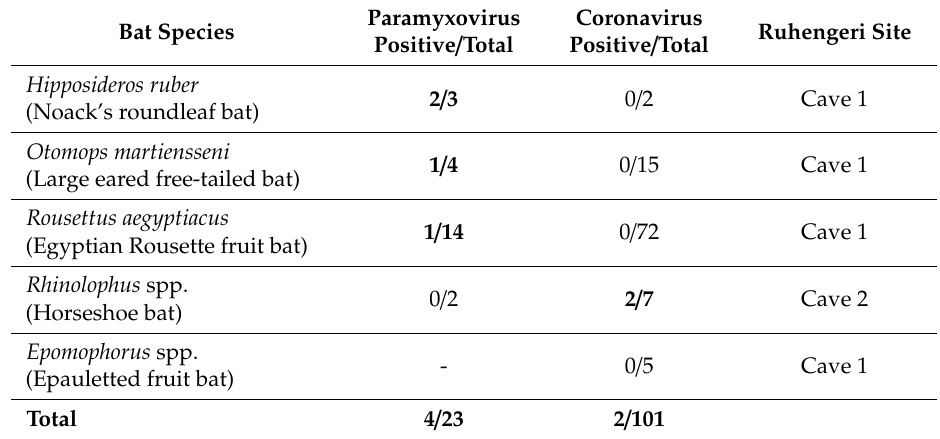
Table 1. Bat-associated paramyxo- and coronavirus RNA detected from bats in the Ruhengeri caves in Rwanda.